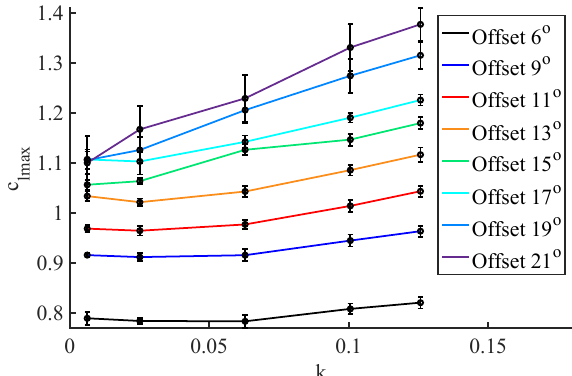
Figure 13. Frequency–domain overview of nine selected experiments grouped by excitation fre- quencies. ( a ) Angle of attack spectra for three 3-levels of excitation, and ( b ) lift coefficient spectra are shown. The green, blue and red bars refer to the excitation at low- (6°), medium- (15°), and high- levels (19°), respectively.